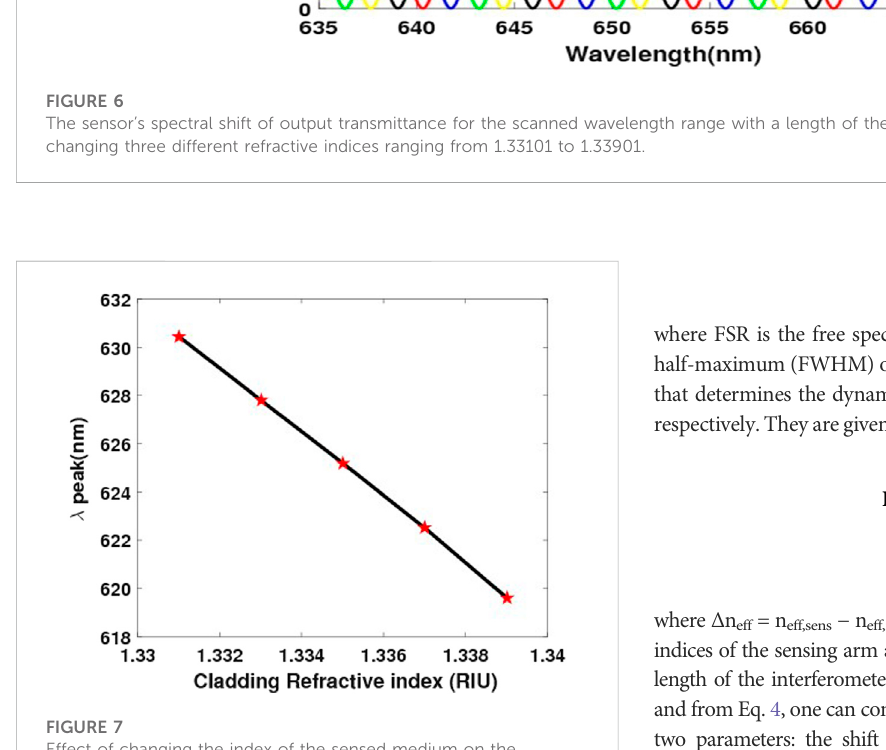
Effect of changing the index of the sensed medium on the wavelength of one of the peaks of its interference pattern. The sensed medium index is varied from 1.31097 to 1.31769 with 0.002